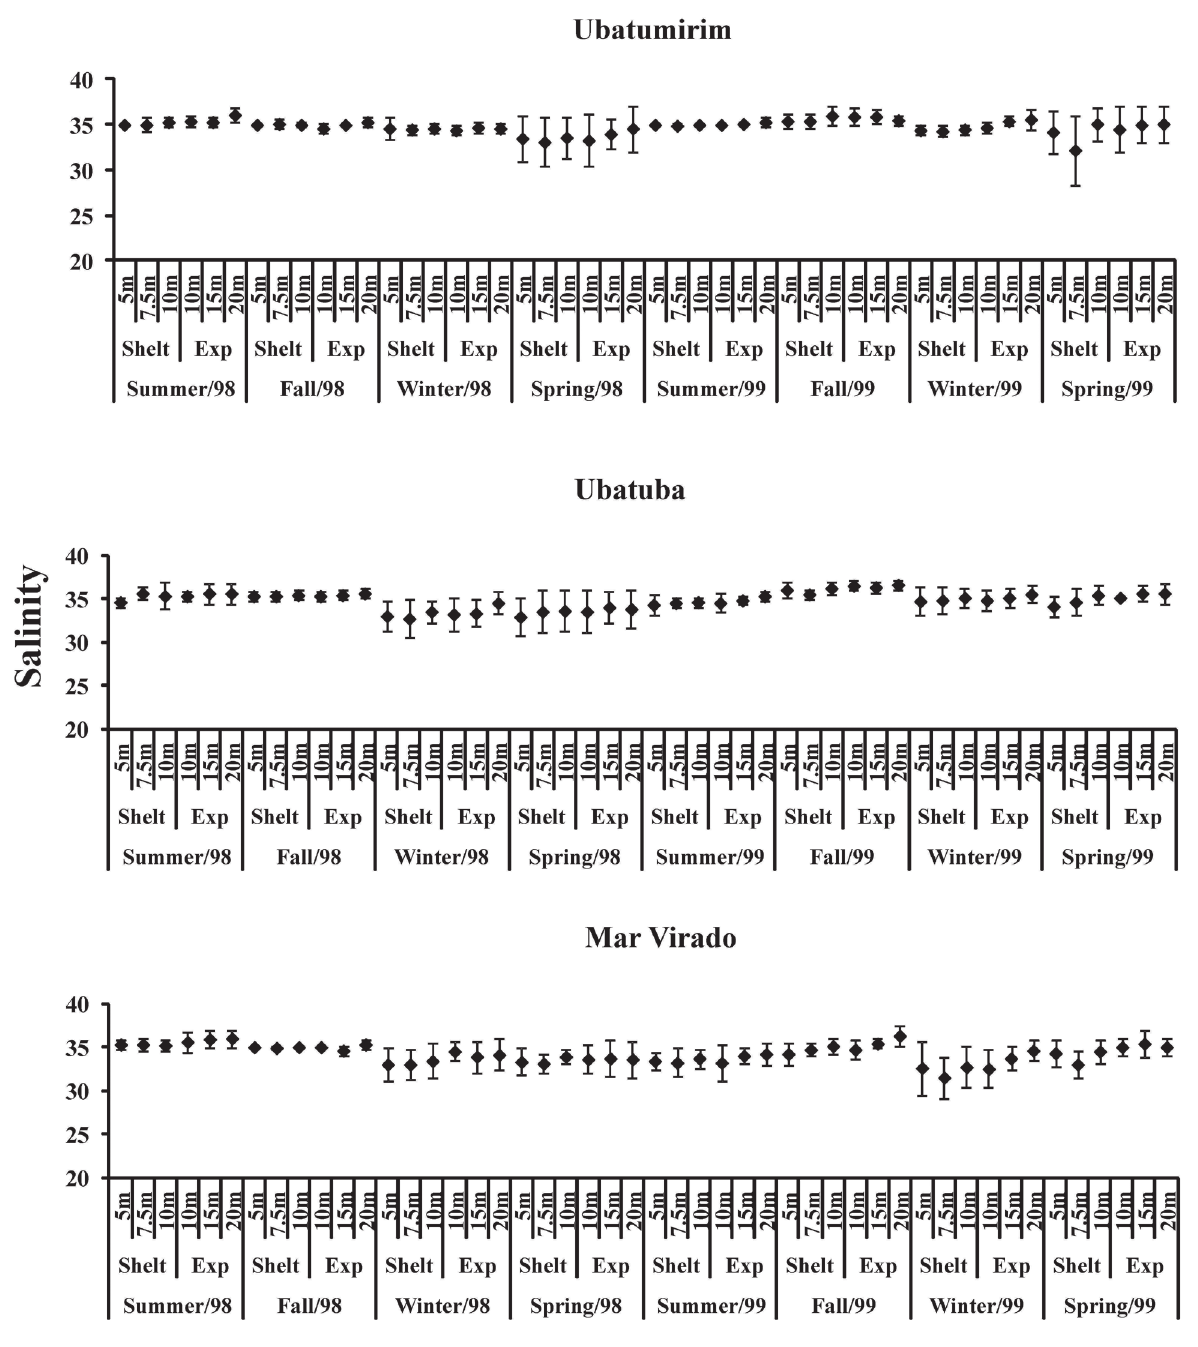
Figure 3. Salinity values variation per seasons, areas and sampling points in 1998 and